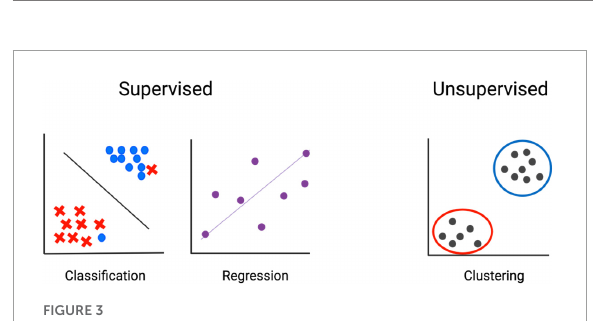
FIGURE3 Machine learning–fundamental concepts. In supervised methods, input data is already classified, and machine learning is used to determine associations. In unsupervised methods, input features are used to determine